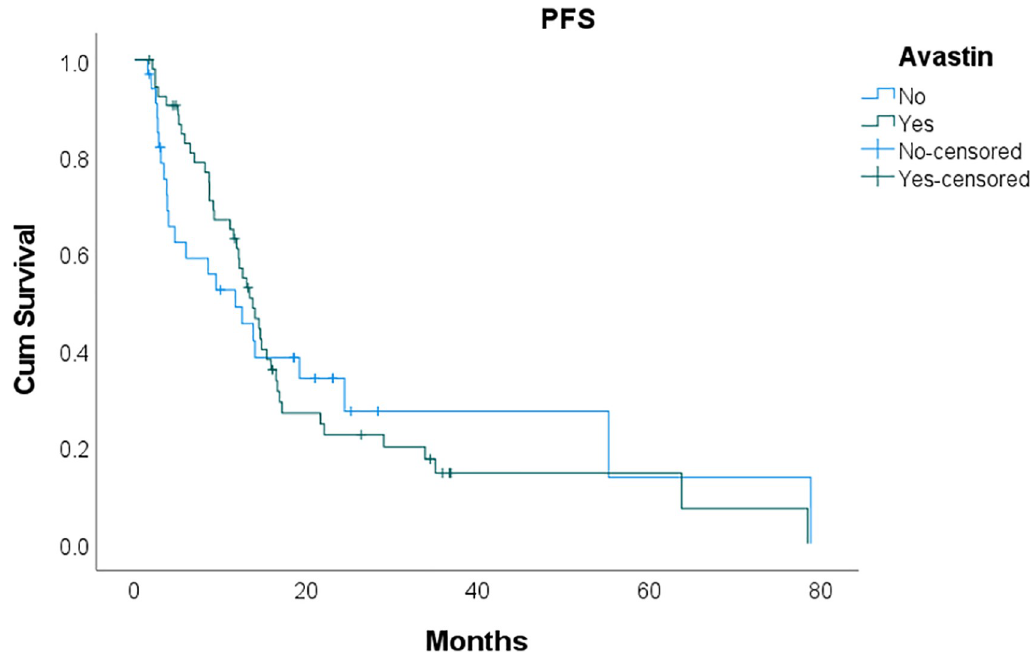
Fig 2. Kaplan-Meier curves of overall survival (OS) and progression-free survival (PFS). No significant difference in OS or PFS was observed between the bevacizumab and systemic chemotherapy